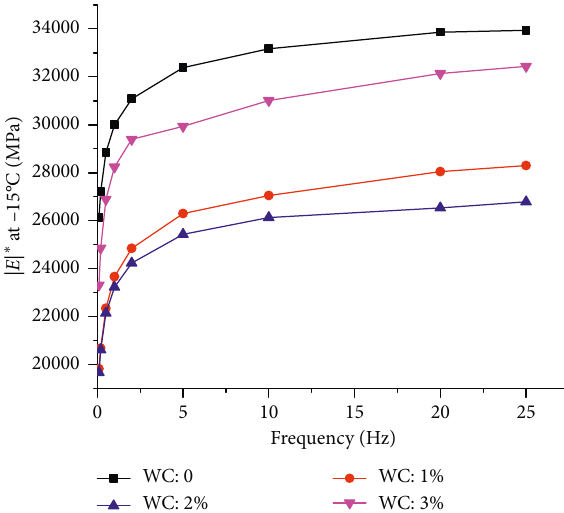
Figure 5: 70#AC-20-type low-temperature dynamic modulus. Figure 6: 90#AC-20-type low-temperature dynamic